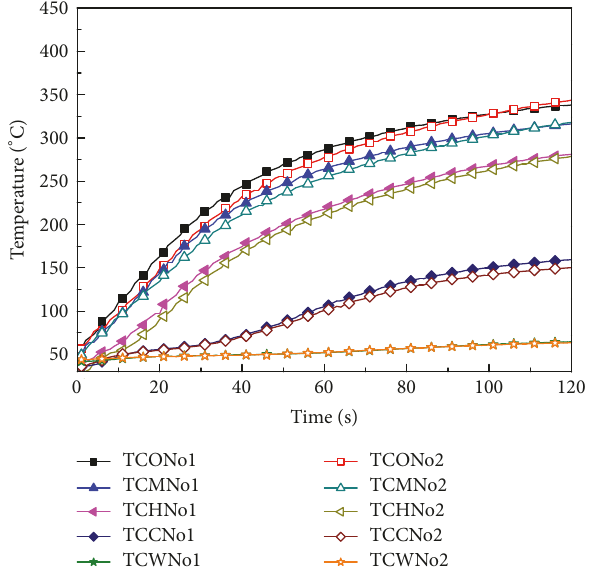
Figure 5: Temperature change with time at different locations.